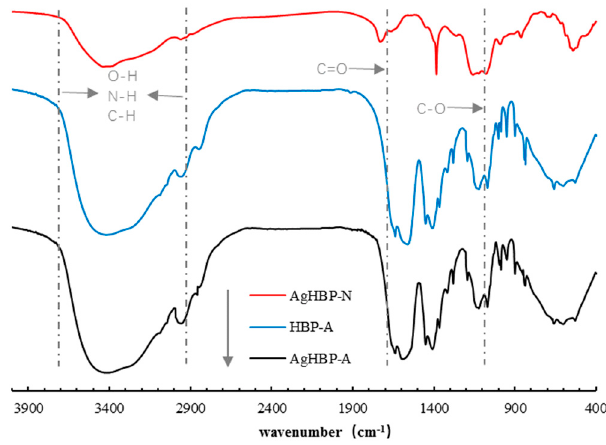
Figure 2. FT-IR spectra of the prepared polymer reactors.